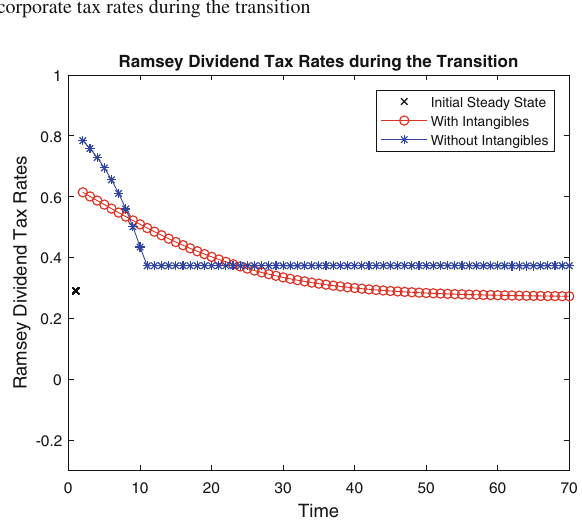
Fig. 2 Ramsey dividend tax rates during the